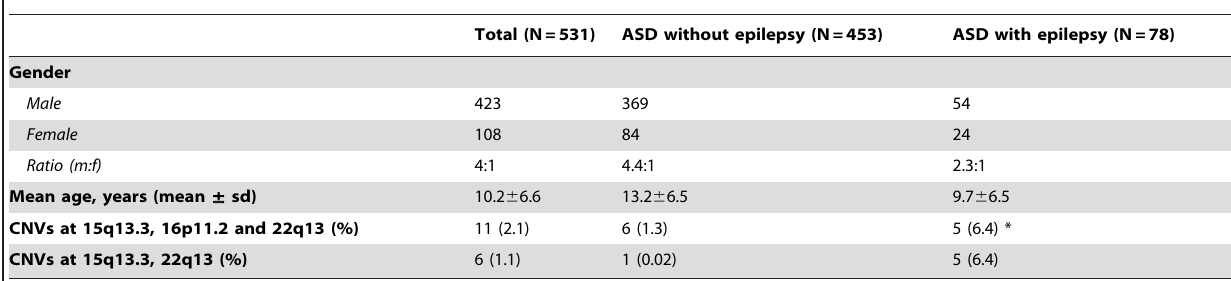
Table 2. Main findings in ASD Brazilian individuals with and without